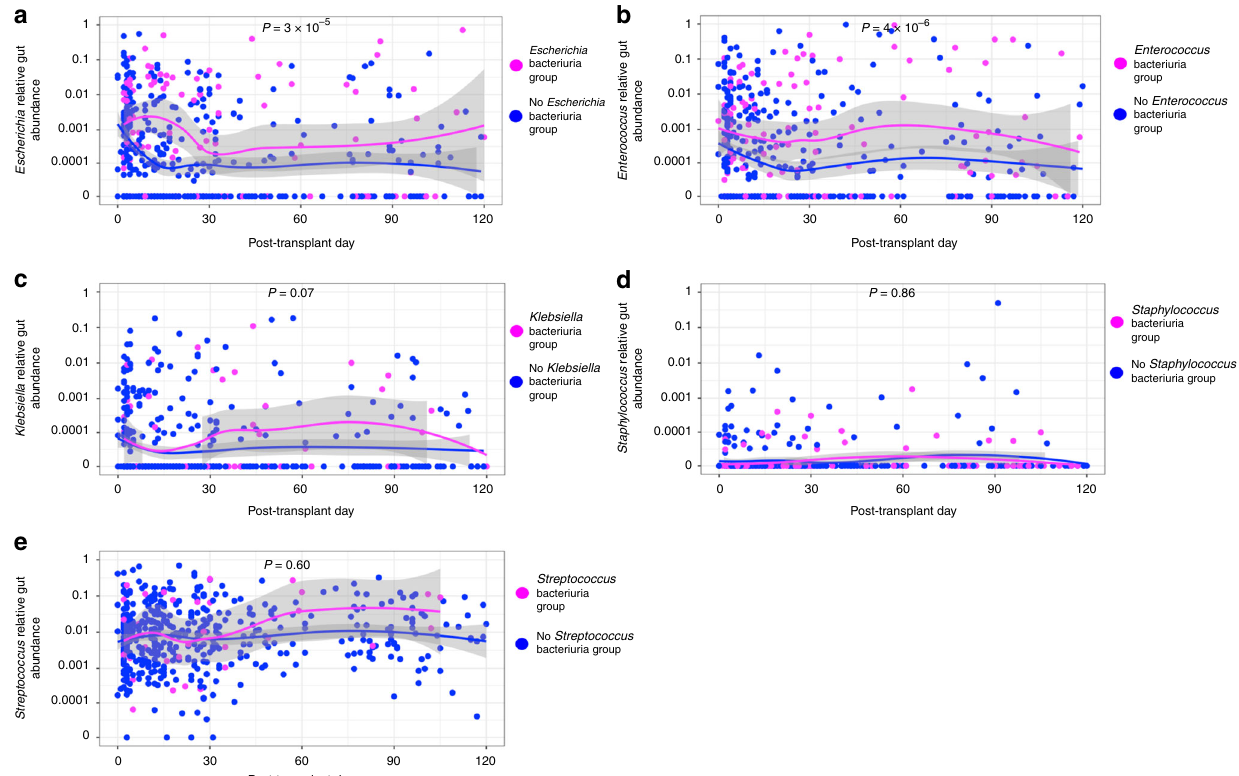
Fig. 1 Temporal dynamics of relative gut abundances and respective bacteriuria. The relative gut abundance of bacteria is on the y- axis (logarithmic scale) and the post-transplant days stool specimens were collected are on the x -axis. The 510 specimens are each represented by a magenta-colored point re fl ecting a specimen belonging to the respective Bacteriuria Group and a blue-colored point re fl ecting the respective No Bacteriuria Group. LOESS curves with 95% con fi dence intervals (in gray) were created by group status. Comparison of relative gut abundances by group status was performed using